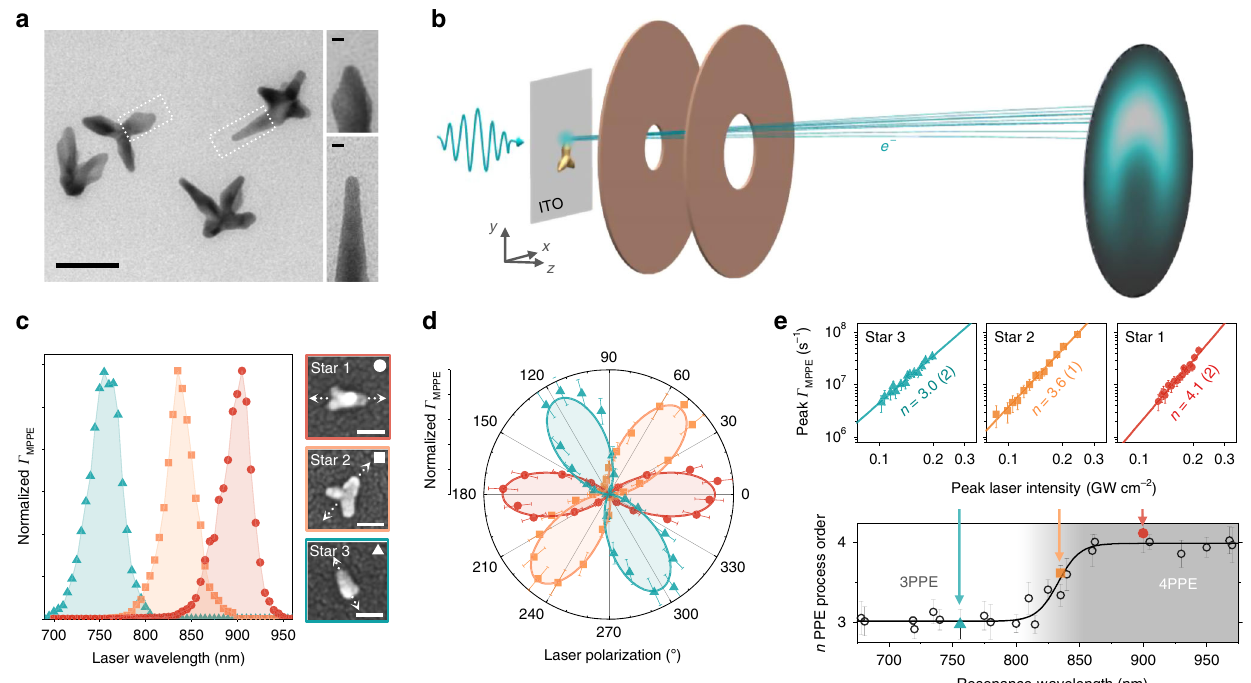
Fig. 1 Single-nanostar plasmon resonance excitation and photoelectron velocity mapping. a Transmission electron micrographs of representative few- arm nanostars (50 nm scale bar) with insets displaying individual tips (5 nm scale bars). b Experimental con fi guration, in which photoelectrons with initial transverse ( v x , v y ) velocity are linearly mapped onto ( x , y ) position on a spatially-resolved microchannel plate detector. c Three example nanostars, each with a single dominant plasmon resonance mode excited via polarization aligned along the arm axes, as indicated by the arrows (50 nm scale bars). d Polarization-dependent photoemission rate at peak resonance wavelengths for each of the three stars, characterizing the peak polarization settings. Data is fi t to cos 2 n ( θ − θ tip ) for multiphoton process order n . e Summary of multiphoton process orders for plasmon resonance modes on different nanostars, determined via linear intensity-dependence fi ts on log – log plots (power-law behavior) as demonstrated for the three example stars. The resulting process order data is fi t to a sigmoidal curve from n = 3.01(3) to n = 3.99(4), demonstrating the clear transition from the three-photon to the four-photon regime with decreasing photon energy. Intermediate values between 3 and 4 are effective process orders representing a weighted average of three- and four- photon contributions. All reported parenthetical values are standard errors of the variance-weighted nonlinear least-squares fi